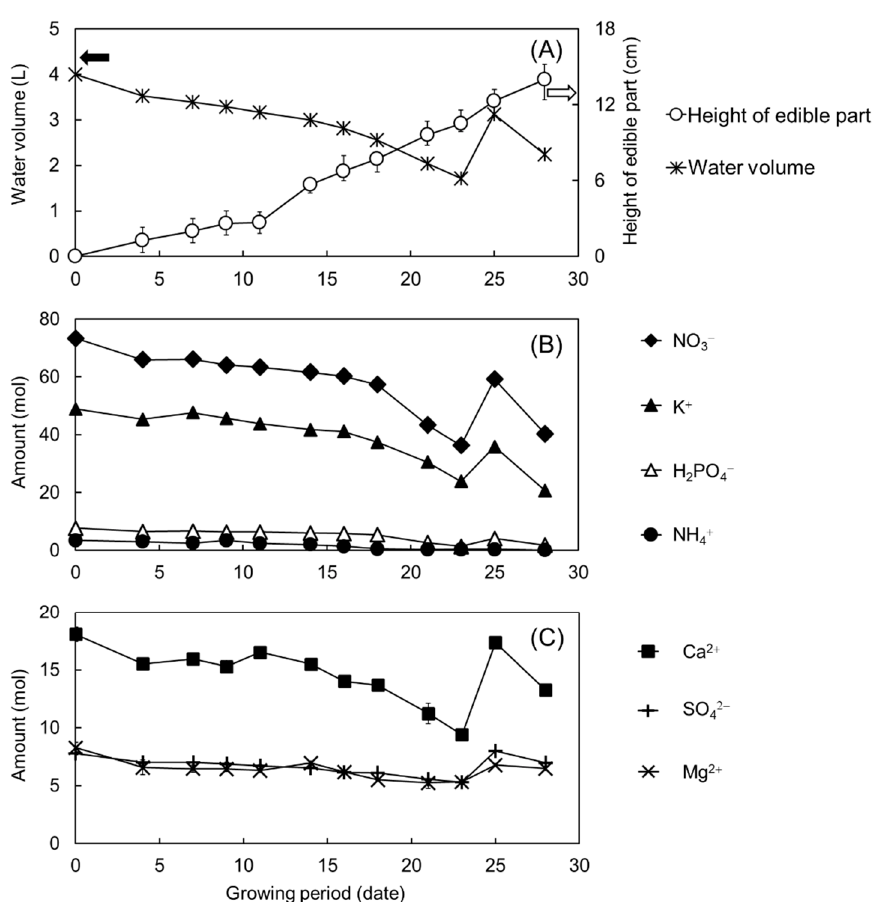
Figure 3. Variations in the height of the edible part, water volume, and amount (mol) of inorganic ionic species in the liquid fertilizer solution under the hydroponic process. ( A ) Height of the edible part and water volume, ( B ) amount of NO 3 − , K + , H 2 PO 4 − , and NH 4+ , and ( C ) amount of Ca 2+ , SO 42 − , and Mg 2+ . The experimental conditions are the same as in Figure 2. Each plot indicates the average and standard errors in three repeated measurements, except the height of the edible part (minimum and maximum values).